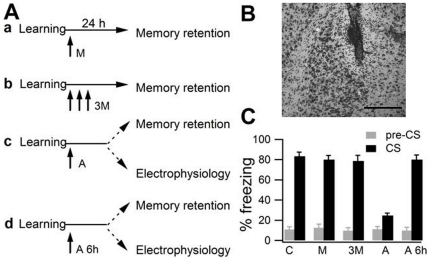
BLA reversible blockade and fear memory consolidation.
A. BLA role in fear memory consolidation was studied by injecting into this site a) muscimol (M) 5 min after training; b) muscimol (M) 5, 90 and 180 min; c) anisomycin (A) 5 min; d) anisomycin (A) 6 h after training. B. Histological control of the location of anisomycin injection into BLA (magnification 10X). Scale bars, 200 µm. C. Memory retention tested in conditioned (C) subjects and in those that received one (M) or three (3M) injection of muscimol, anisomycin (A) 5 min or 6 h (A 6 h) after conditioning.